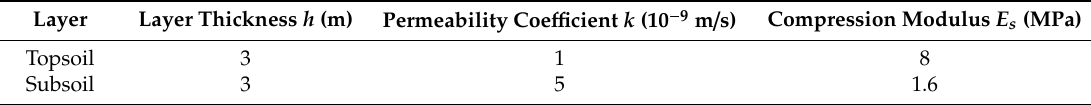
Table 3. Study data of semi-permeable boundary